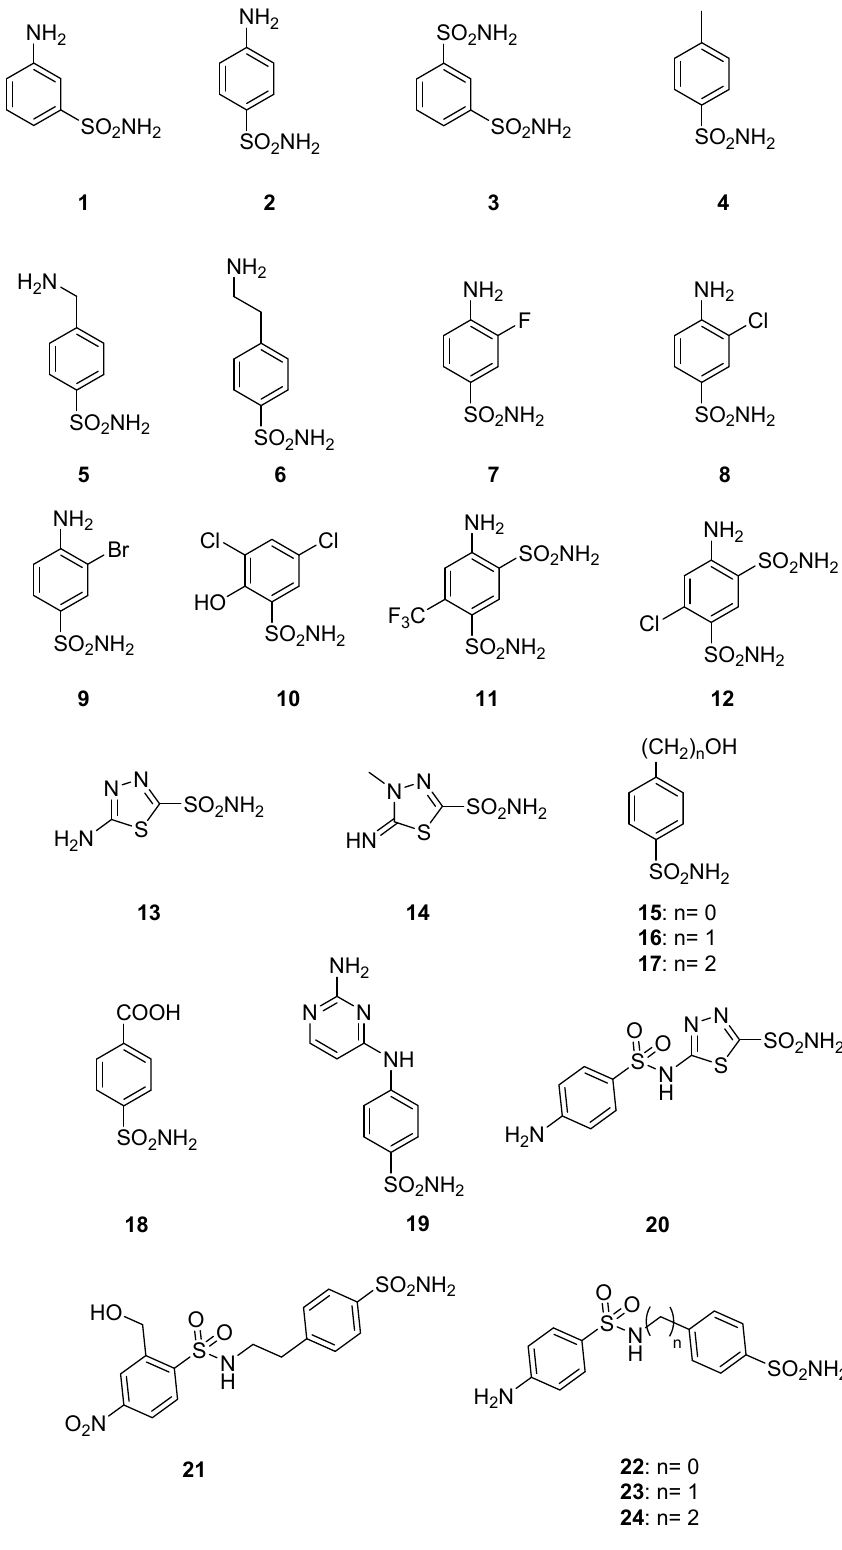
Figure 1. Structures 1 − 24 .